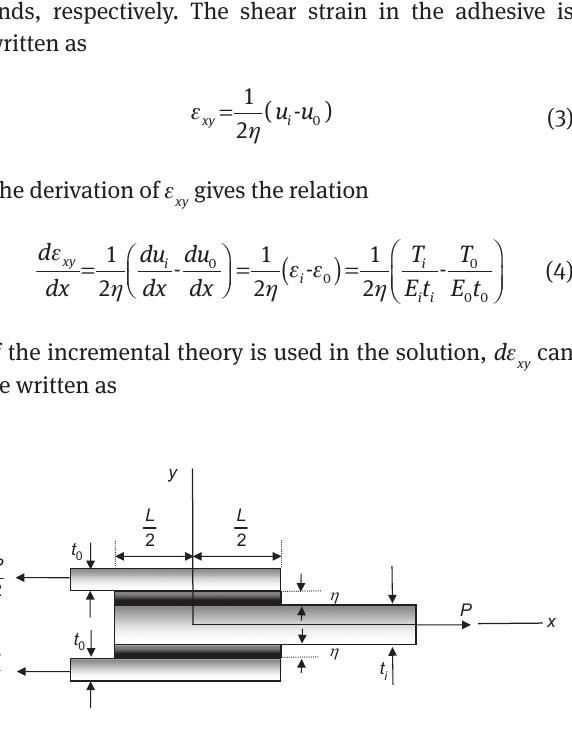
Figure 2 . The static equilibrium yields the following equa- tions as